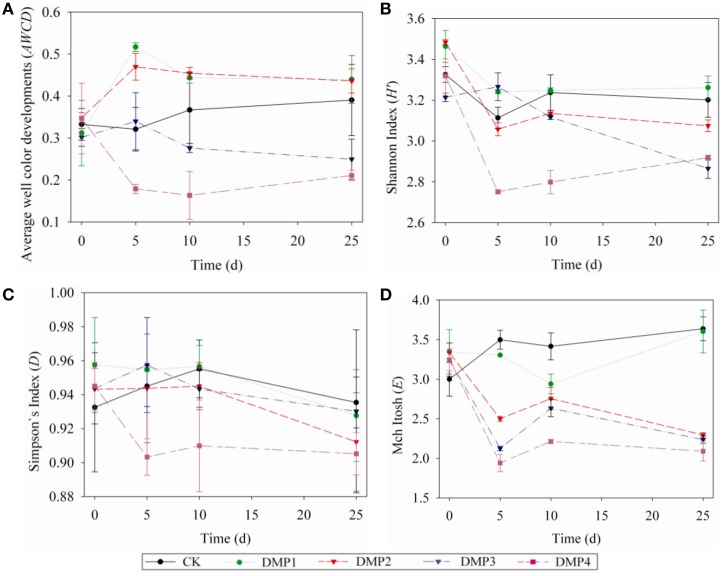
The dynamic changes of bacterial activity and functional diversity on the microbial communities generated from the five DMP treatments (CK, DMP1, DMP2, DMP3, and DMP4) on black soil microorganisms within 25 days incubation in the dark at 25°C and 70% relative humidity. (A) Average well color development (AWCD); (B)
H′ index (Shannon index); (C)
D index (Simpson index); (D)
E index (McIntosh index). The error bars indicate standard deviations (n = 3).